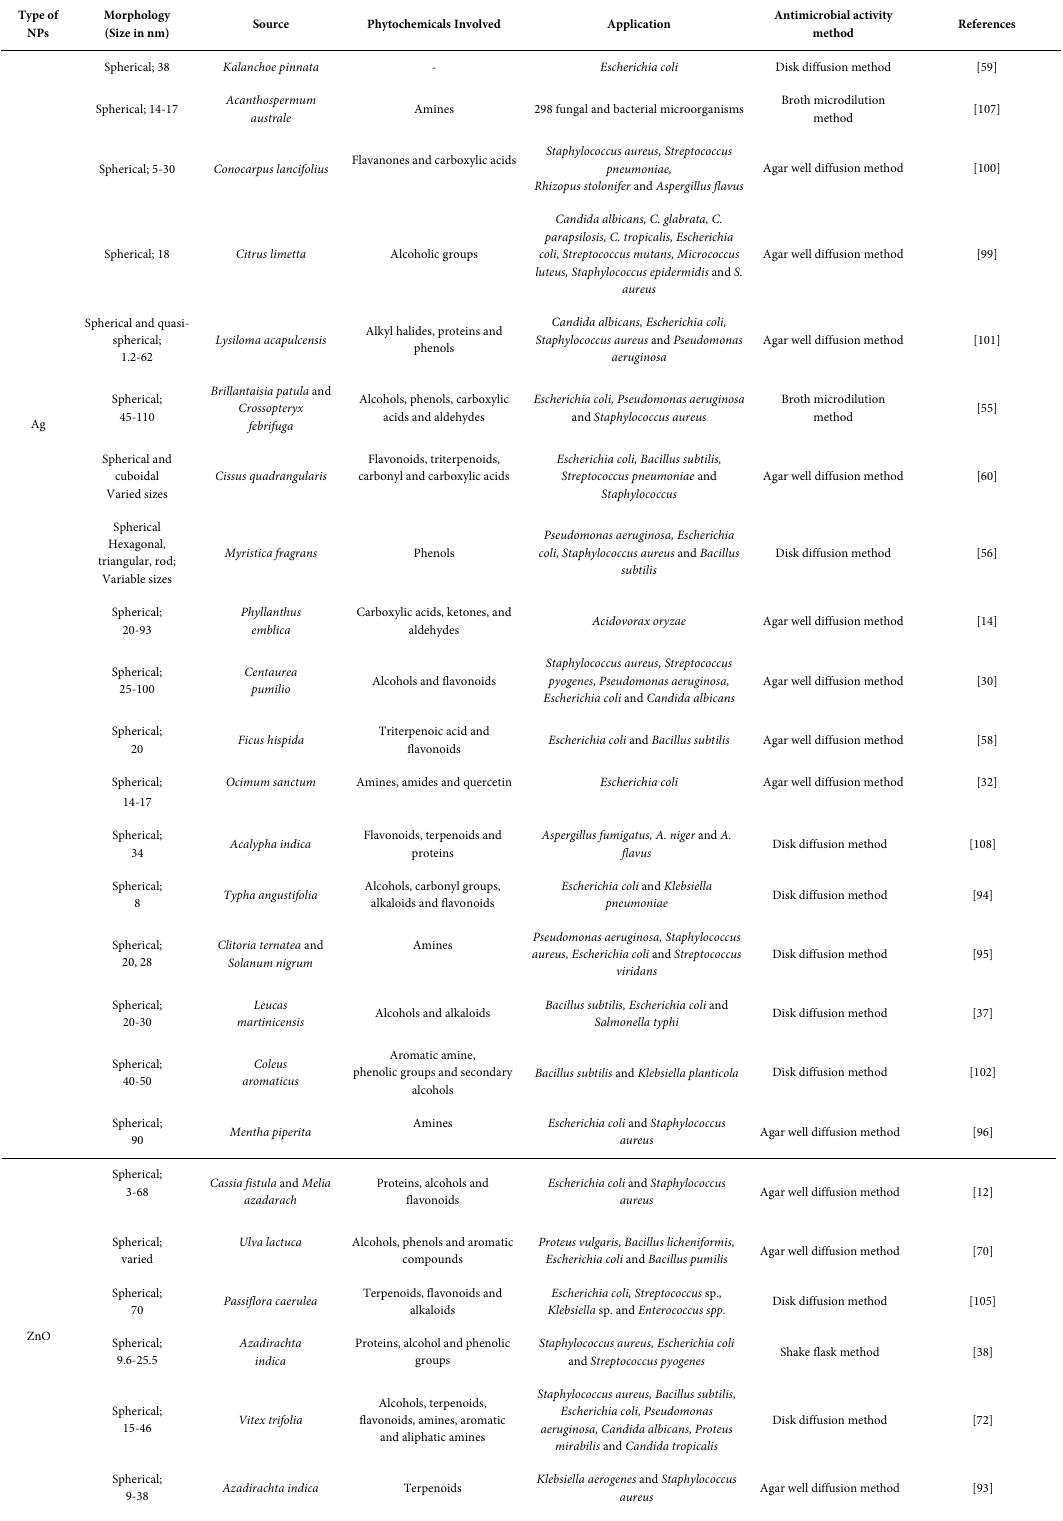
Table. 4 Antimicrobial activity of inorganic nanoparticles synthesized using